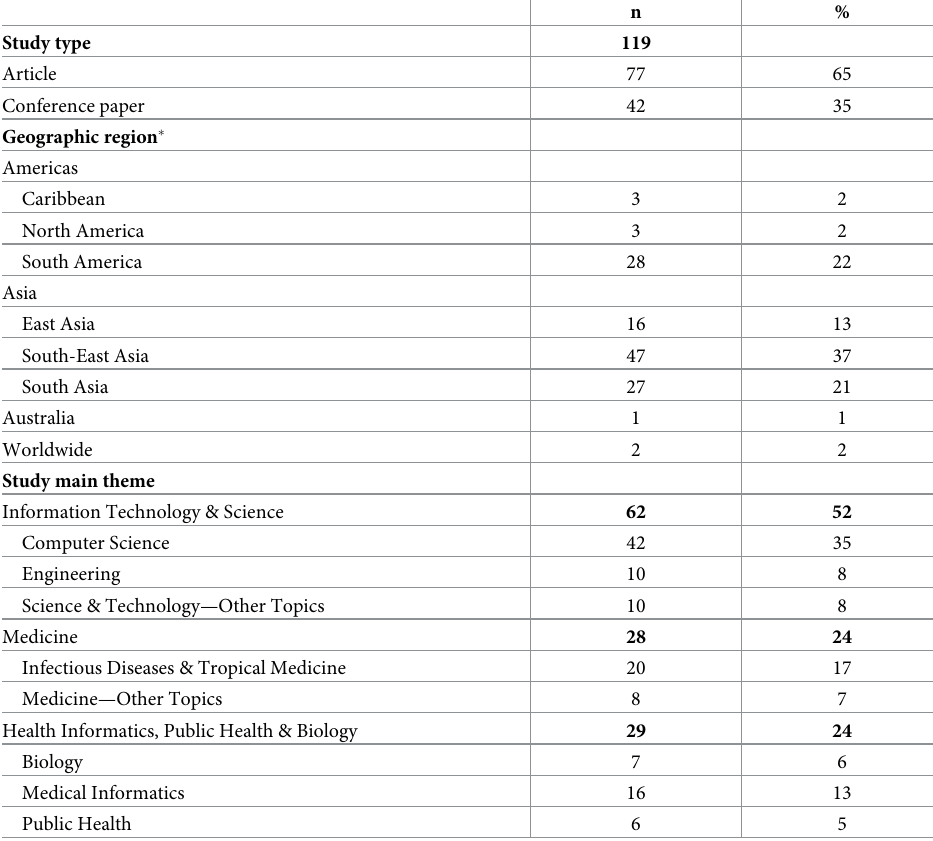
Table 1. Type, study population and themes of the selected studies.